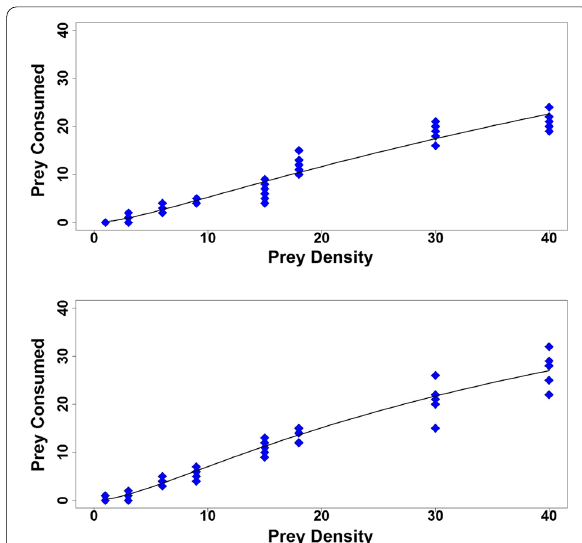
Fig. 1 a Functional response of fifth instar of Dortus primarius at different prey density of Frankliniella schultzei larvae during a 24 h period. b Functional response of adult female of Dortus primarius at different prey density of Frankliniella schultzei larvae during a 24 h period